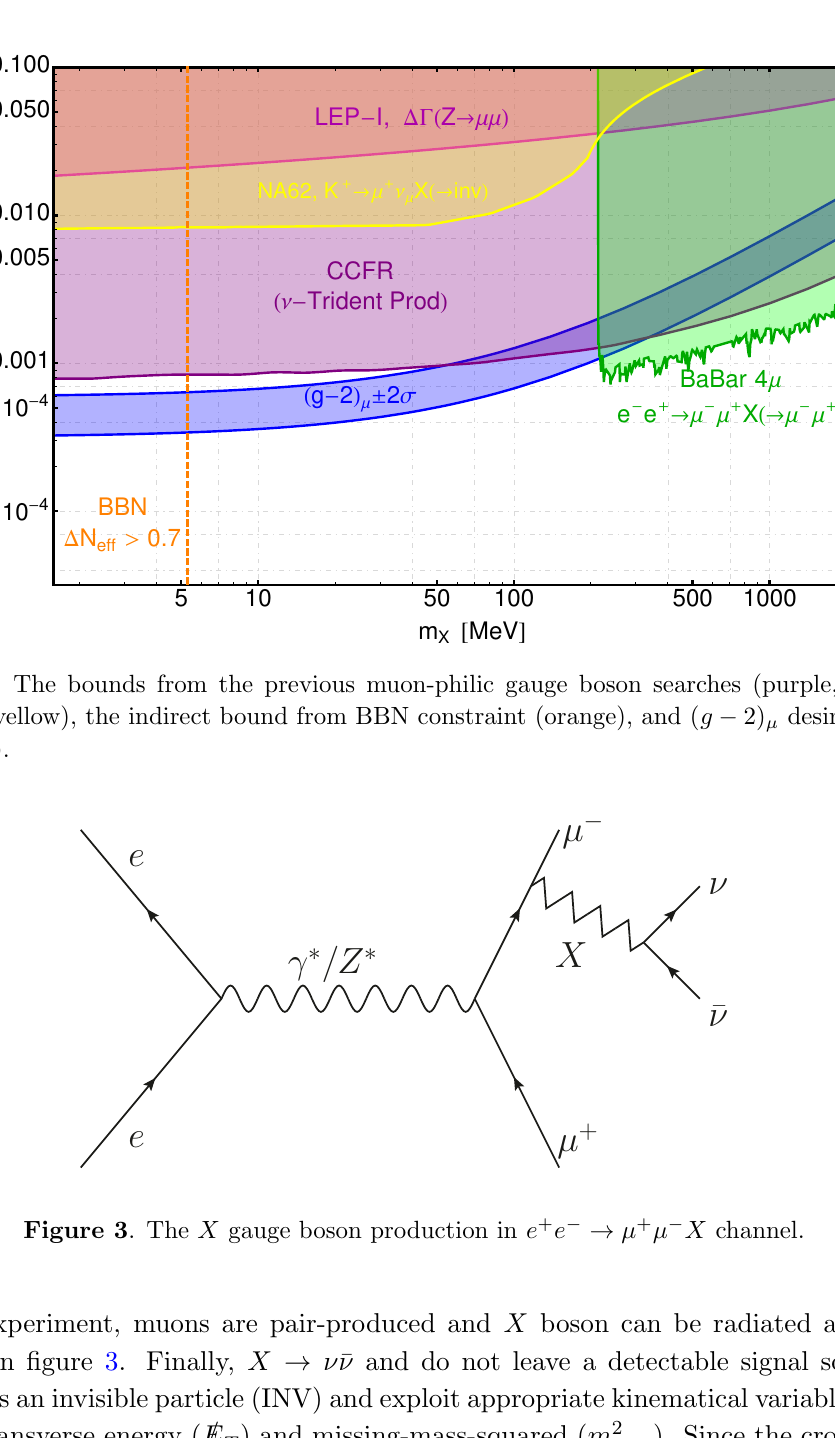
(cid:22) + (cid:22) (cid:0) X !